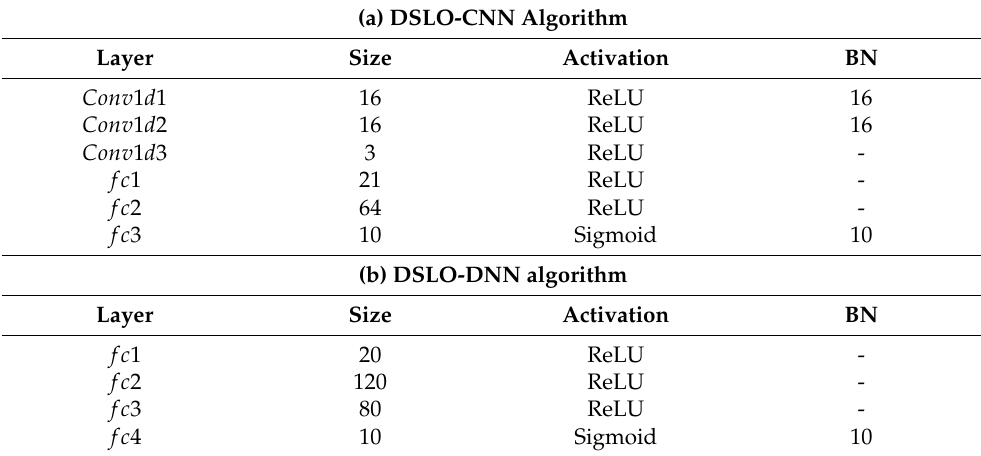
Table 1. The parameters of DLSO-CNN and DSLO-DNN algorithm